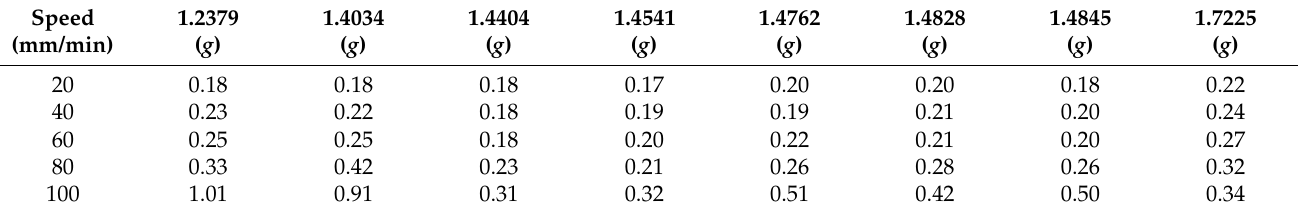
Table 13. Vibrations measured in the z -axis in relation to the respective steel and the traverse speed.